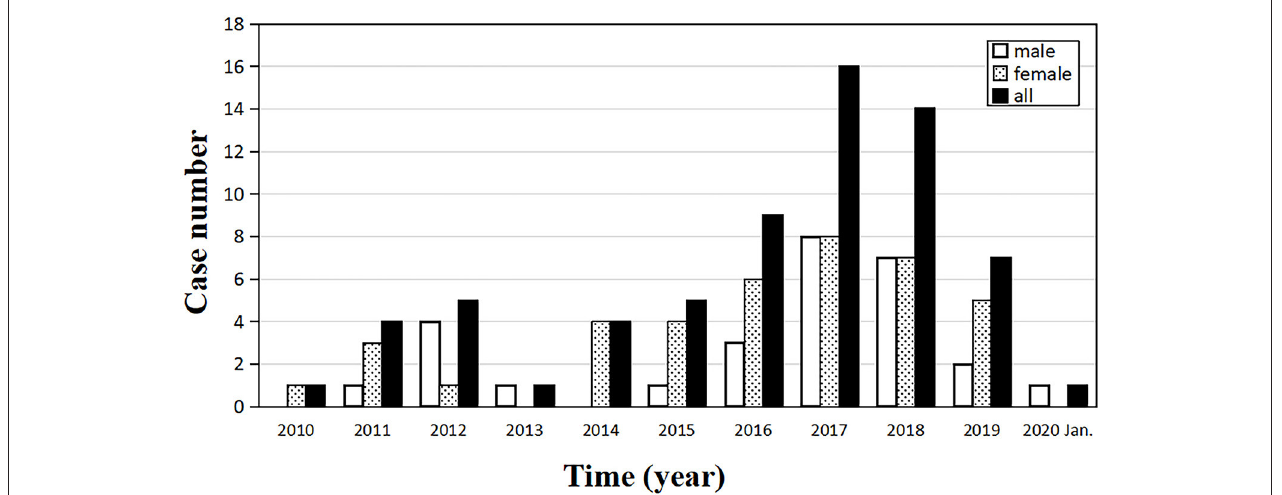
FIGURE 1 | Annual distribution of the number of sporadic Creutzfeldt–Jakob disease (sCJD) patients, from January 2010 to January 2020 ( n = 67).